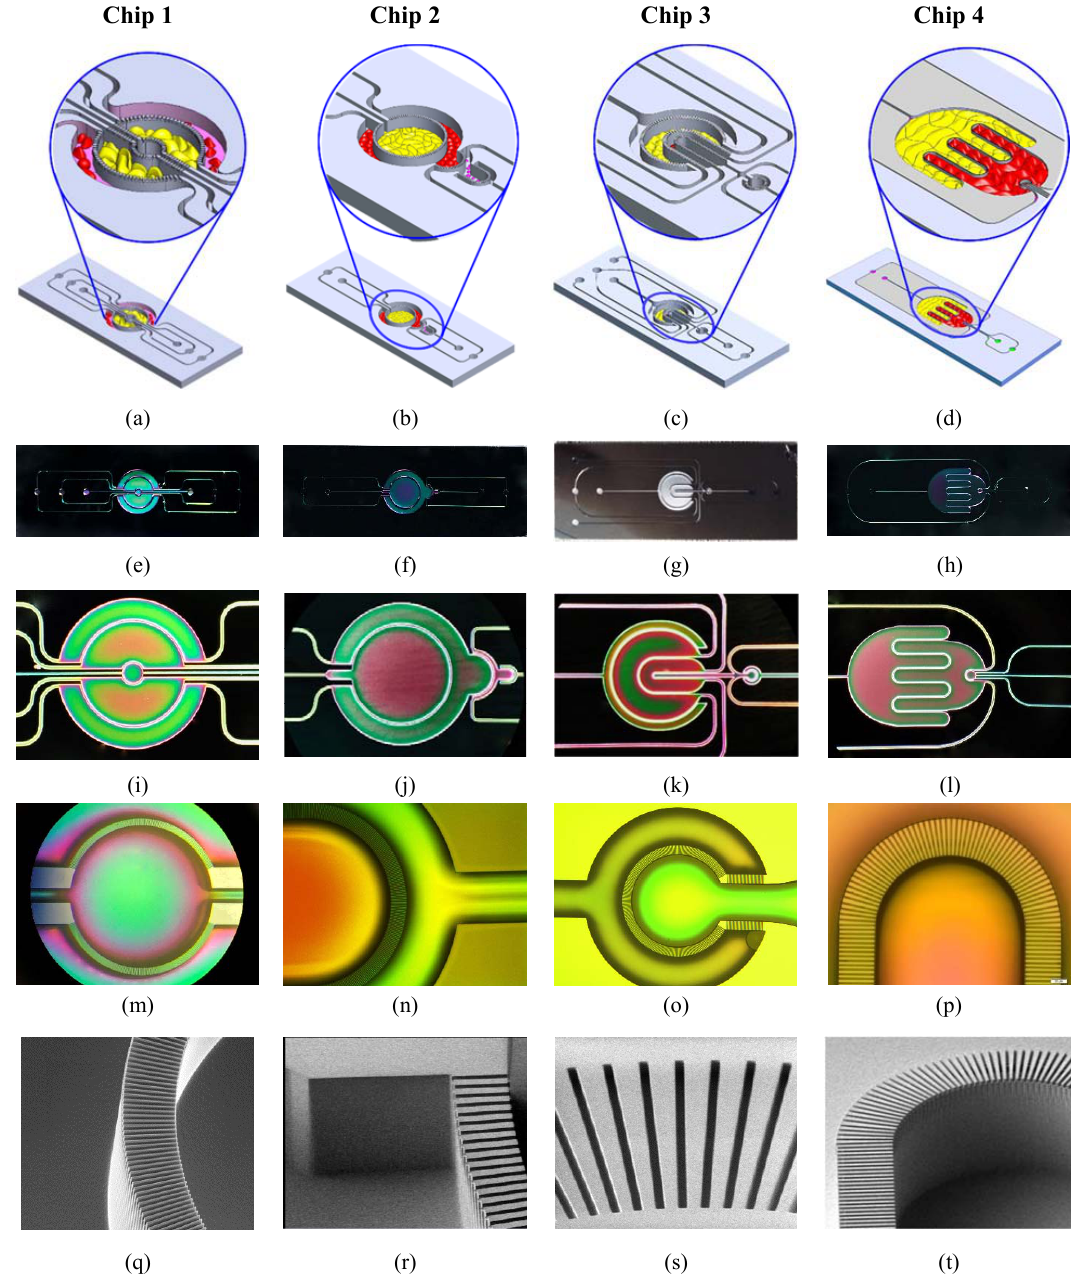
Figure 2. The fabricated and tested devices. ( a – d ) 3D schematic drawing of the chip with a detailed view of the compartmentalized structure. ( e – h) Optical images of the fabricated devices. (i – l ) Detailed view of the compartmentalized structure. ( e – h ) Optical images of the fabricated devices. (i – l ) Detailed views of the cell culture compartments. ( m ‐ p) Detailed views of key structures. ( q – t ) SEM images of views of the cell culture compartments. ( m – p ) Detailed views of key structures. ( q – t ) SEM images of the porous barrier. the porous